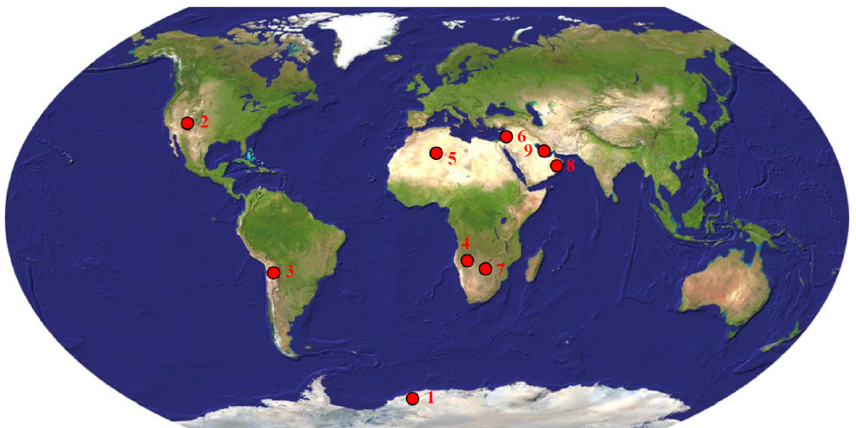
Figure 2. Collection locations of natural dust samples (in alphabetical order): (1) Antarctica, (2) Arizona, (3) Bolivia, (4) Etosha, (5) Hoggar, (6) Israel, (7) Makgadikgadi, (8) Oman, (9)